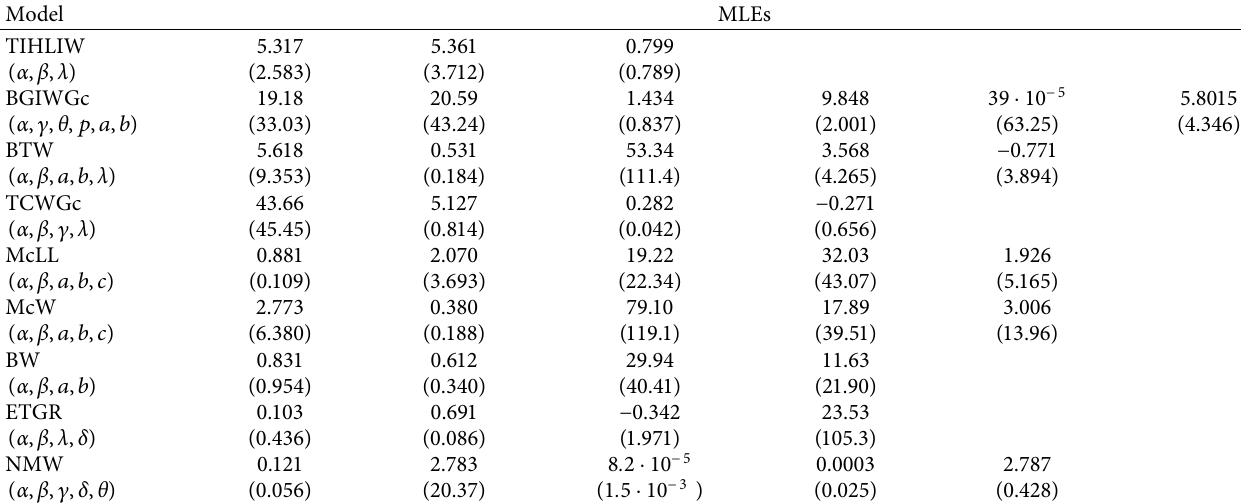
Table 5: MLEs and SEs for relief times